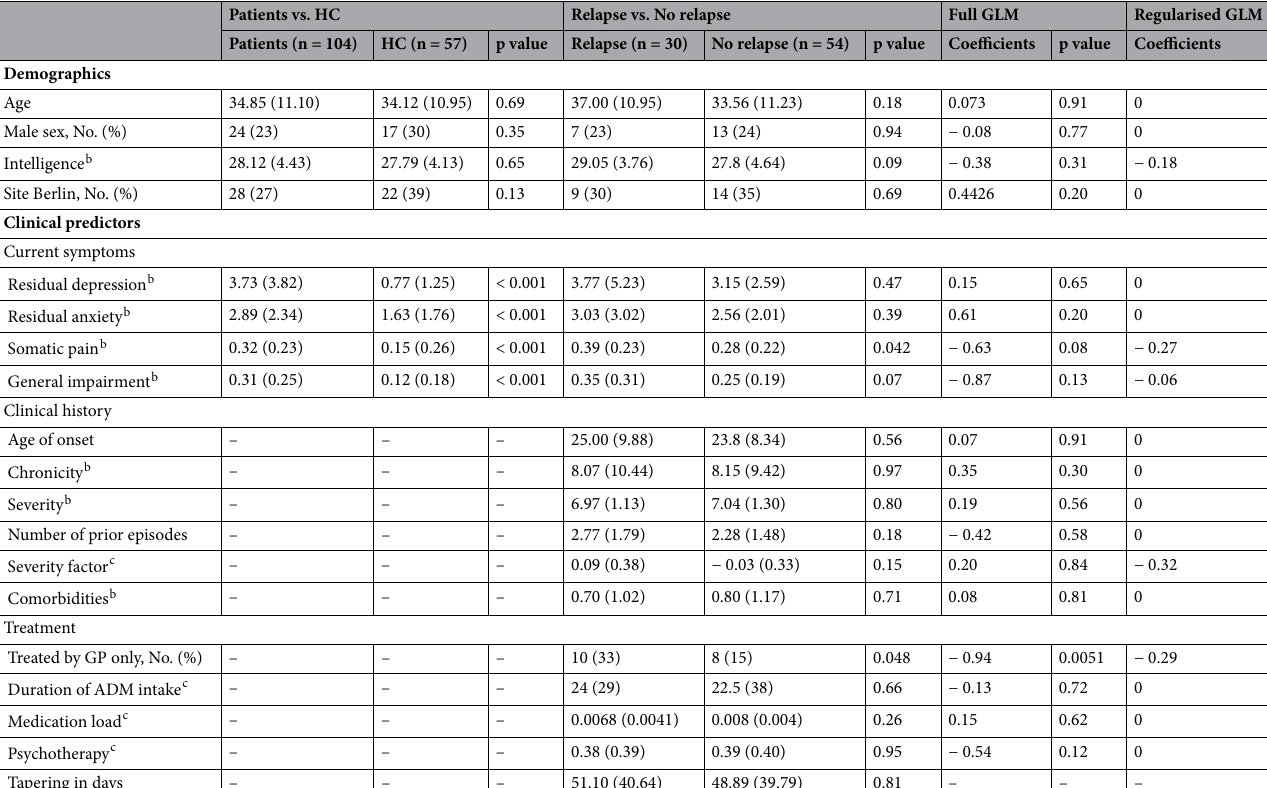
a Table 1. Participant characteristics and complete-case analyses. Unless stated otherwise, mean (SD) are b shown; Determined as follows: intelligence: Mehrfachwahl Wortschatz Test 38 ; residual depression: Inventory of Depressive Symptomatology-Clinician Rated 39 ; residual anxiety: screening generalised anxiety disorder (GAD-7 40 ); somatic pain: somatisation subscale of symptom checklist 90 (SCL-90 41 ); general impairment: global severity index of SCL-90; chronicity: numbers of months sick within the last 5 years; severity: symptoms c during the last episode; comorbidities: number of past and present psychiatric diagnoses; Computation of the variables is described in the Section S1.4; GP general practitioner, ADM antidepressant medication, HC healthy controls, GLM general linear model. Intercept for regression models not